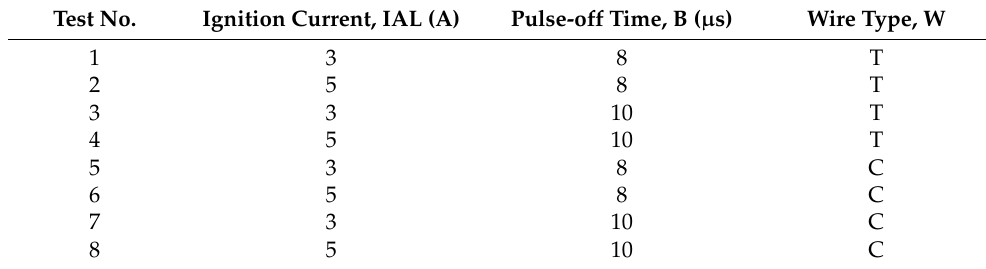
Table 3. Full factorial experimental array. Test